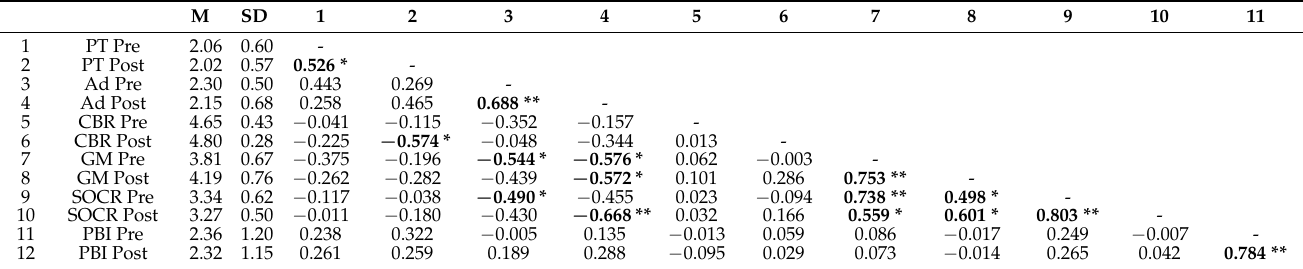
(Table 1) and the Wilcoxon signed-rank test (Table 2) compared scales scores between pre- and post-surveys. Table 1. Descriptive statistics.